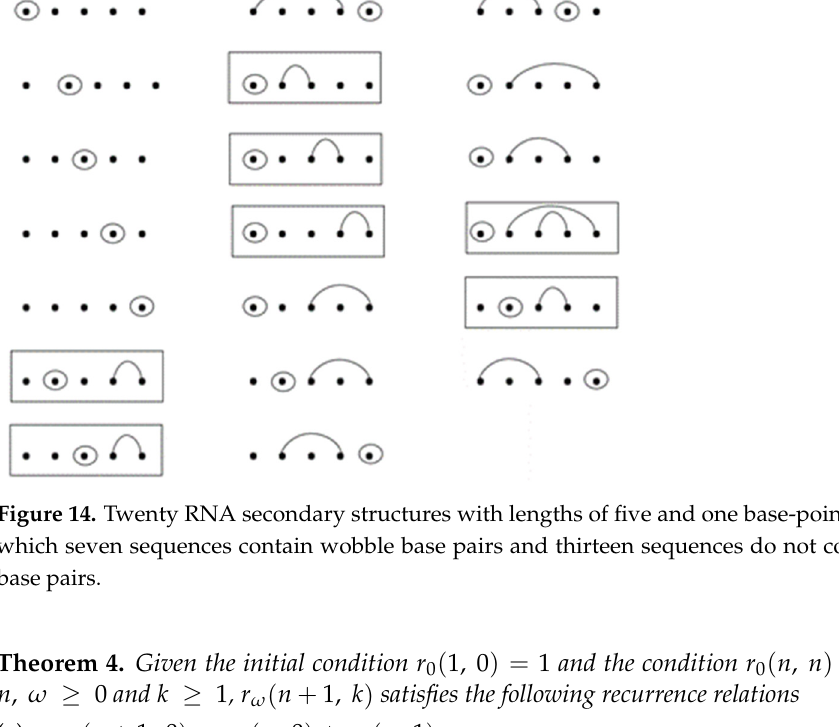
16 Figure 13. Example of constructing the seven sequences with mutations and wobble base pairs. Thus, the lower triangular RNA array  ∗∗ is interpreted as the number of RNA sec- ondary structures with base-point mutations that contain wobble base pairs. Recall that wobble base pairs represent all entries of  ∗∗ except for the entries of the leftmost column. Since the combinatorial arguments in the proof for Proposition 1 are similar to the combi- natorial arguments in the proof of Theorem 4, we omit a formal proof for Proposition 1. Let  = w( − 1,  + 1) where w( − 1,  + 1) counts RNA structures of length  − 1 that have  + 1 mutations and contain wobble base pairs. Let   (, ) denote the